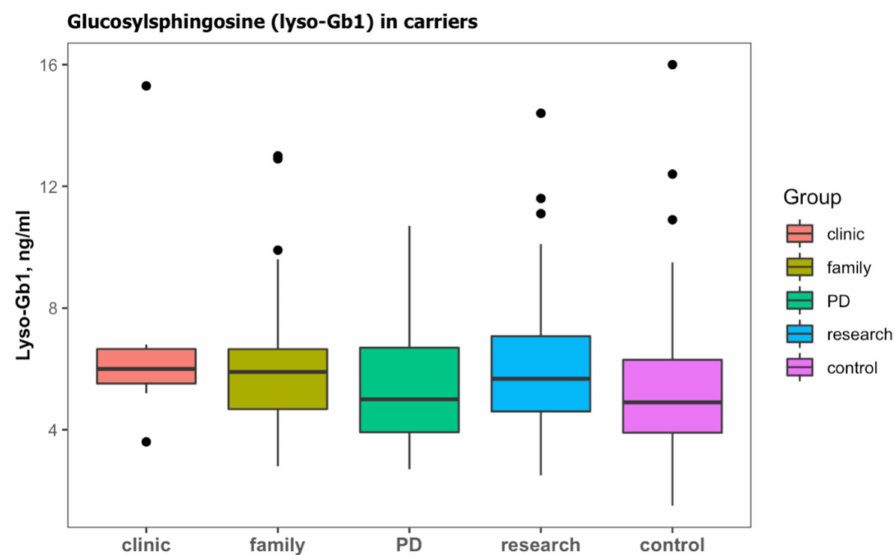
Figure 4. Lyso-Gb1 levels in subjects with monoallelic variants in GBA1 (carriers) according to the cause for sending a sample; clinical features (clinic), family history of GD (family), Parkinson’s disease (PD), and subjects enrolled on a study of prodromal Parkinson’s disease (research). Lyso-Gb1 levels of subjects with wild-type GBA1 were considered to be the control. Black dots represent the outliers.